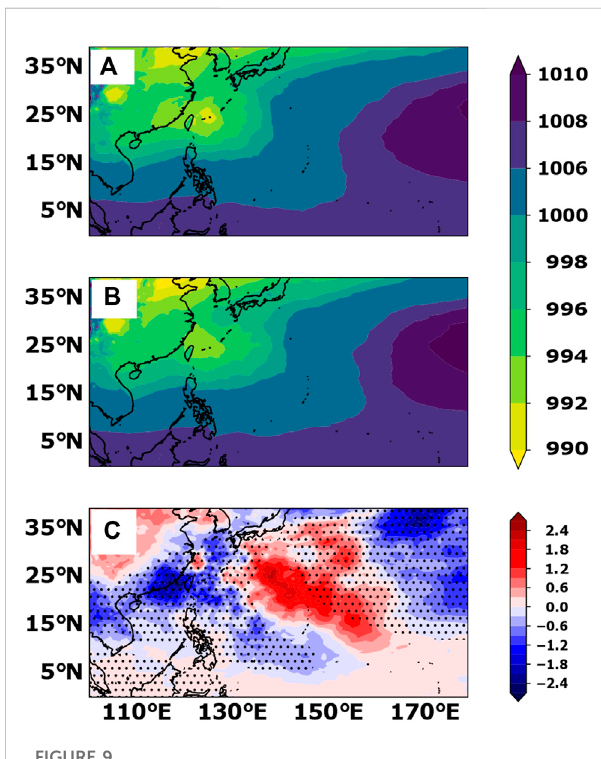
FIGURE 9 Spatial map of the bottom 1 percentile SLP from 01 June to 30 September for the period (1951 – 2005): (A) HIST (B) HISTNAT (C) (HIST — HISTNAT). Dots indicate the statistical signi fi cance levels ( p < 0.05) based on Student ’ s